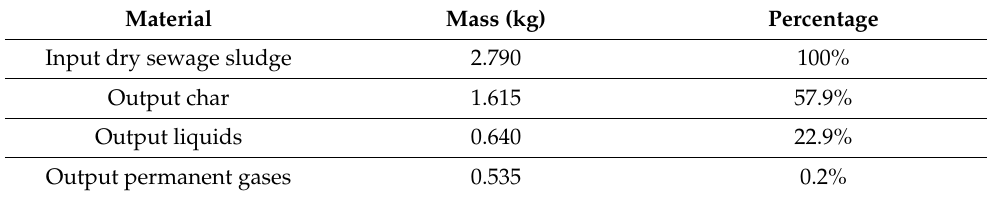
Table 7. Mass balance of the dry feedstock (sewage sludge) slow pyrolysis test on SPYRO pilot plant. Material